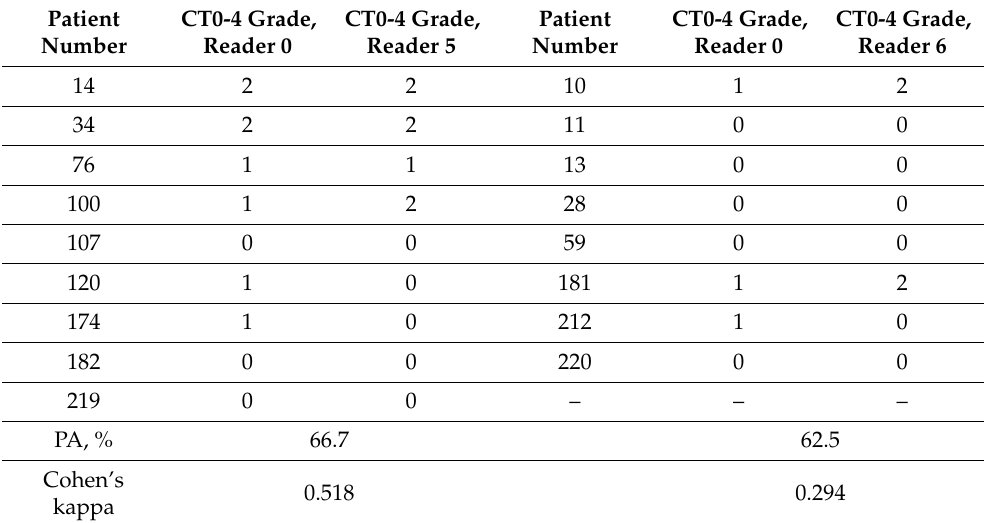
Table A1. Example of differences between percent agreement and Cohen’s kappa